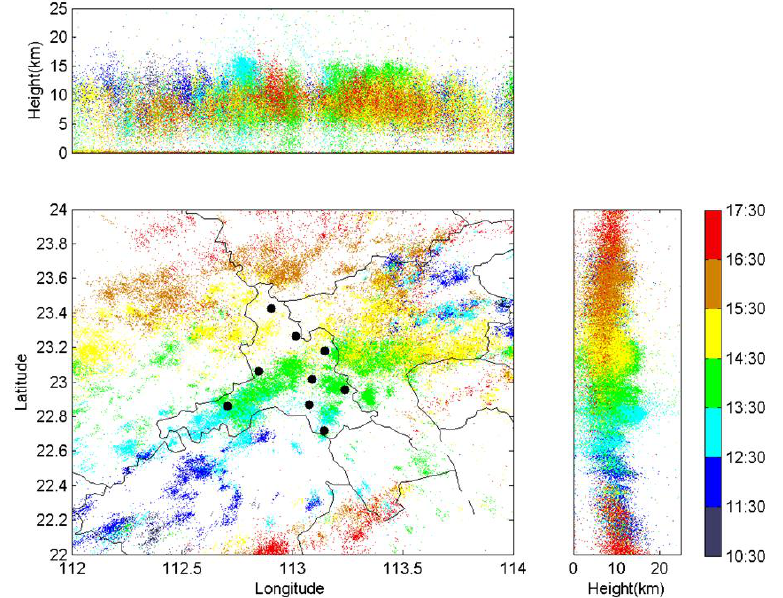
Figure 13. Evolution of an overhead thunderstorm mapped by the FTLLS on 19 August 2014. Stroke locations for all types are shown in the latitude/longitude panel and vertical sections, the black dots are locations of the nine sub-station of the FTLLS.